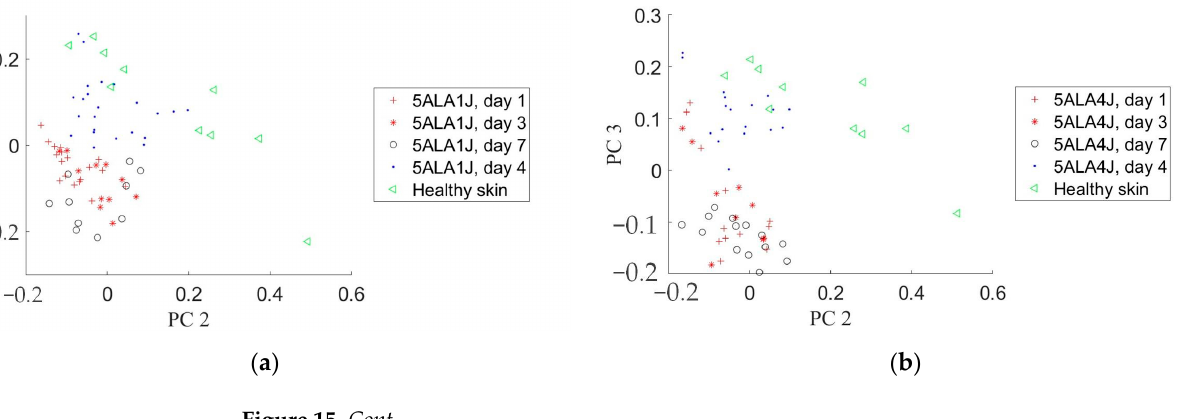
( d ) ( e ) Figure 15. Principal component analysis of the wound and healthy skin Raman spectra in the 2800– 3000 cm − 1 spectral range on different observation days in a subspace of PC2 and PC3: ( a ) 5-ALA 1 J/cm 2 group, ( b ) 5-ALA 4 J/cm 2 group, ( c ) MB 1 J/cm 2 group, ( d ) MB 4 J/cm 2 group, ( e ) the control group. To calculate the Mahalanobis distance, the PCs space was scaled, so that, in the PCs subspace, the healthy group was inside the area with a radius 𝑟 calculated using the following formula: 𝑟 = (cid:3493)𝜎 (cid:2870)(cid:2870) + 𝜎 (cid:2871)(cid:2870) , (4) where 𝜎 (cid:2870) and 𝜎 (cid:2871) are standard deviations for the PC2 and PC3 coordinates of the healthy group samples, respectively [61]. To simplify calculating the distance, the PCs space was normalized so that the radius r was equal to √ 2. After scaling PCs space, the Mahalanobis distances between distributions of healthy skin and other groups’ Raman spectra PCs were calculated using Equations (2a) and (2b). Table 3 presents the Mahalanobis distance in the PC2–PC3 space between the healthy skin and 5ALA 1 J/cm 2 , 5ALA 4 J/cm 2 , MB 1